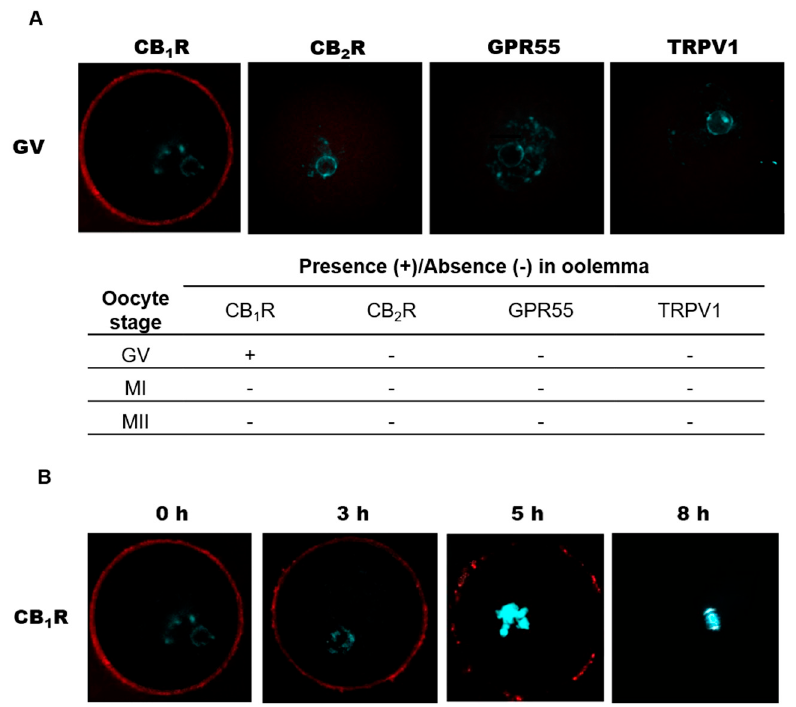
Figure 3. Distribution of CB 1 R, CB 2 R, GPR55, and TRPV1 in the oolemma and CB 1 R localization at oolemma during in vivo GV–MI transition. ( A ) Only GV oocytes showed detectable signals. Qualitative data are expressed as presence (+) or absence (-) of fluorescence in 15 oocytes/sample. ( B ) CB 1 R distribution, analyzed at different times after human chorionic gonadotropin (hCG), changed from uniformly homogeneous (0–3 h) to dotted clusters (5 h), until complete disappearance at MI (8 h). Each image was taken at the equatorial plan of the oocyte. Cy-3: red, DAPI: cyan. Magnification: ×630.